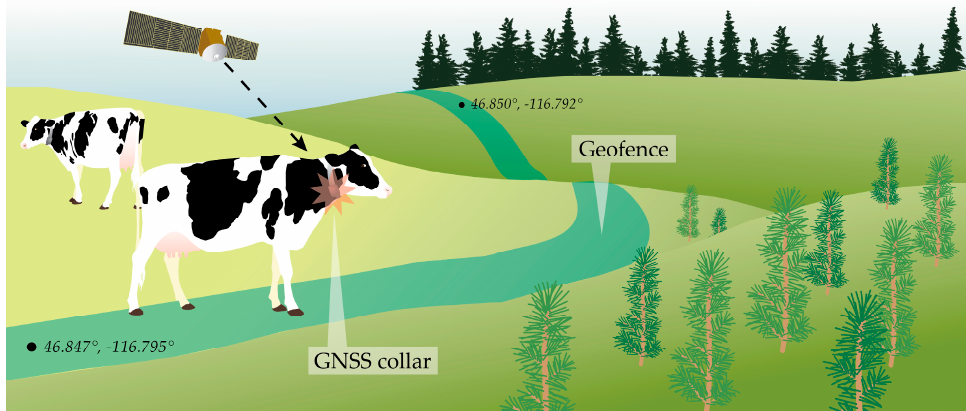
Figure 12. Example use of a geofence to separate grazing from newly planted conifer seedlings. The virtual fence is defined by a series of GNSS coordinates. When a GNSS collar worn by livestock approaches the boundary, an alerting sound or sensation is triggered.